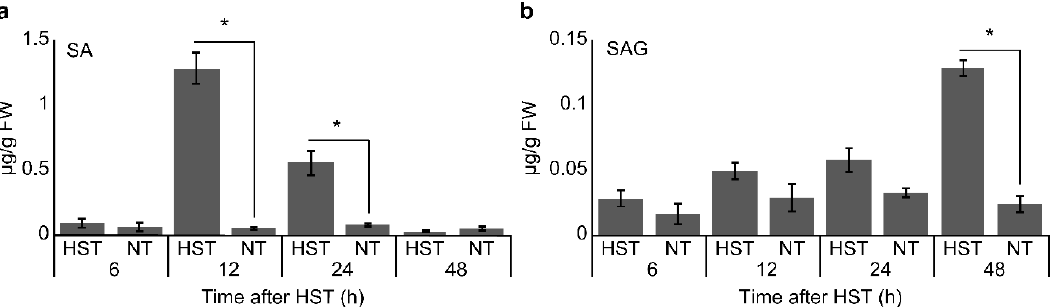
Figure 5. Accumulation of ( a ) salicylic acid (SA) and ( b ) salicylic acid b- D -glucoside (SAG) at 6, 12, 24 and 48 h after HST. Vertical bars indicate the standard error of the mean ( n = 3). Significant differences between groups (indicated by asterisks) were obtained from performing two-tailed t -tests, p < 0.05. FW, fresh weight.